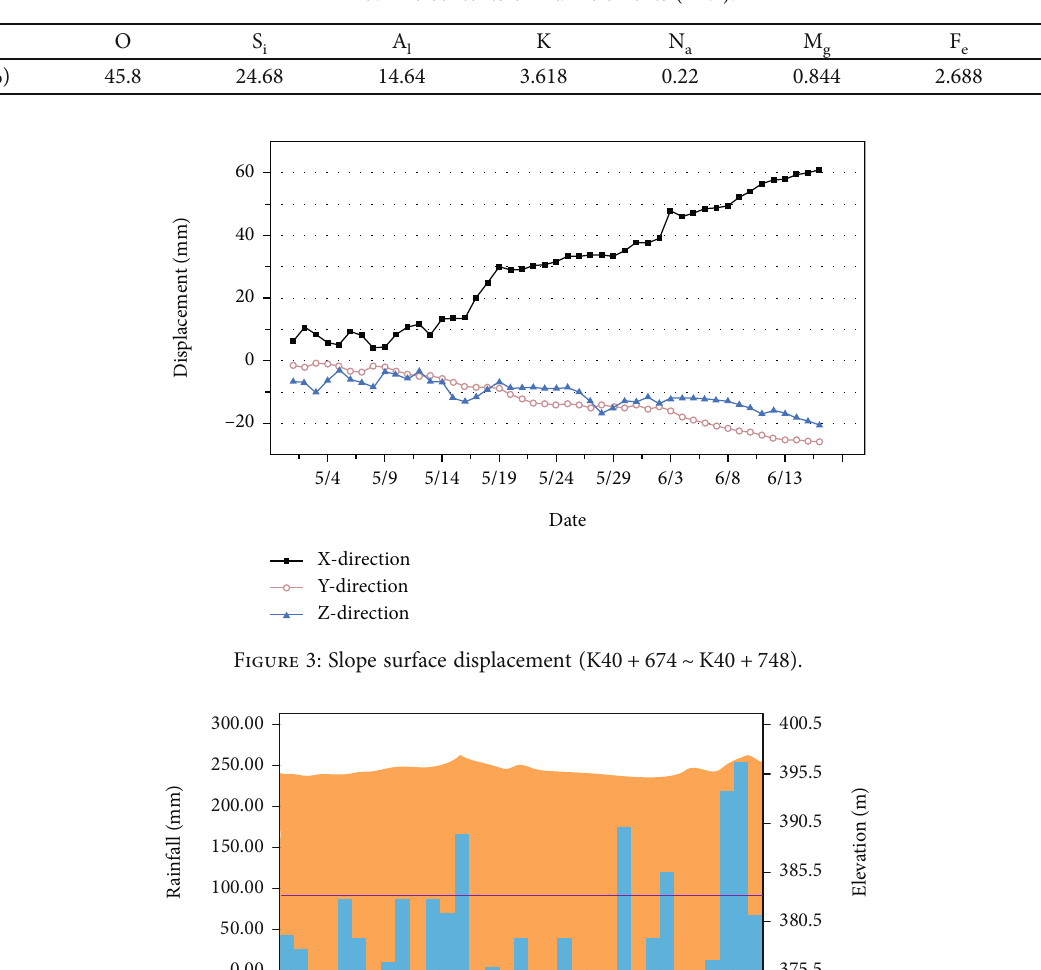
Table 5: The contents of main elements (XRF).